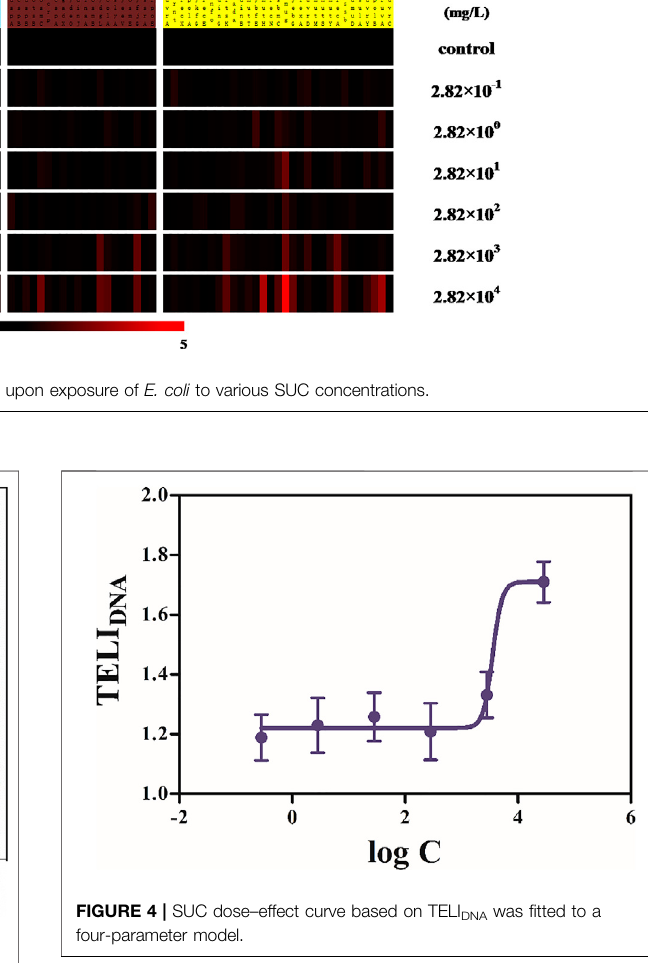
FIGURE 3 | Overall stress response TELI values of E. coli exposed to various SUC concentrations.